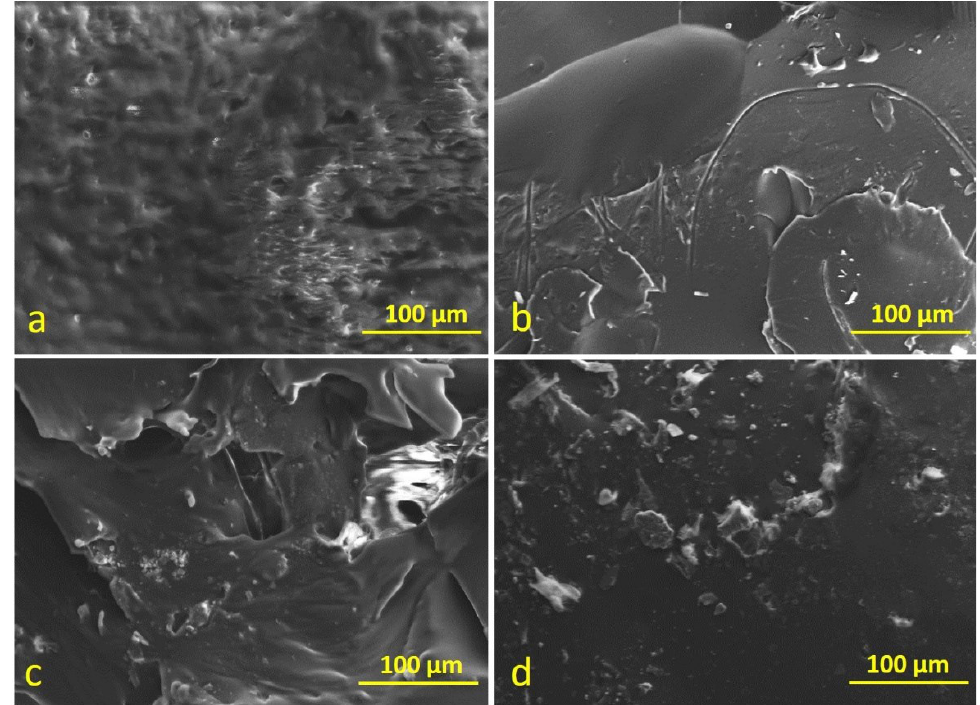
Figure 14. SEM images of bitumen specimens before aging: ( a ) C, ( b ) 5PC, ( c ) 5PTFE, ( d ) 2.5PC-2.5PTFE.